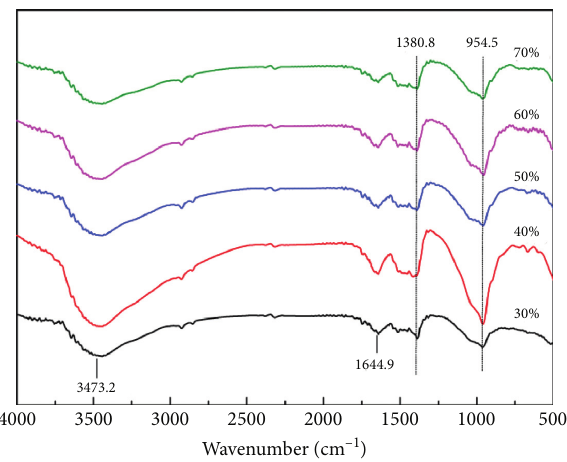
Figure 12: FTIR spectra of the